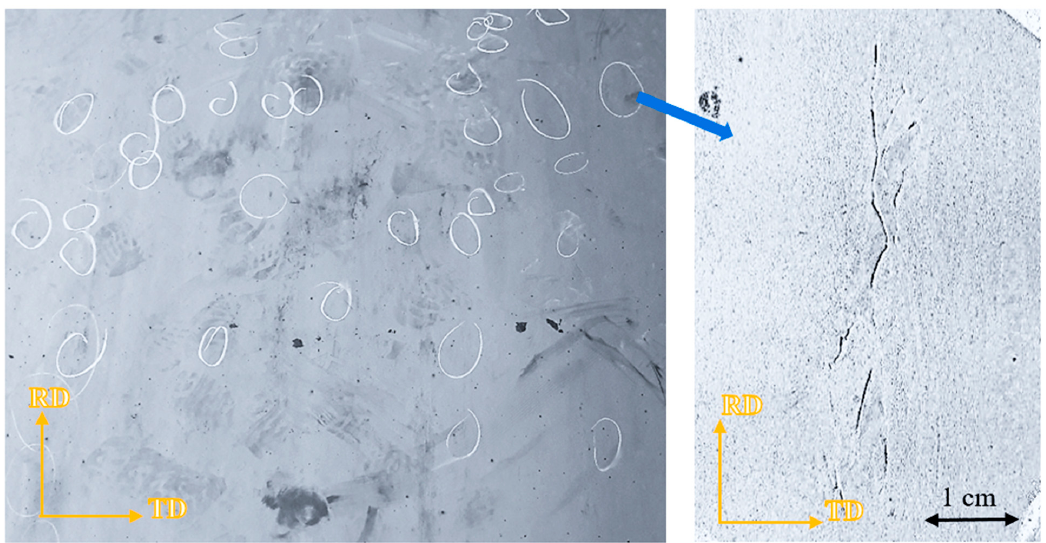
Figure 2. Visual appearance of surface cracks on the surface of heavy plates.